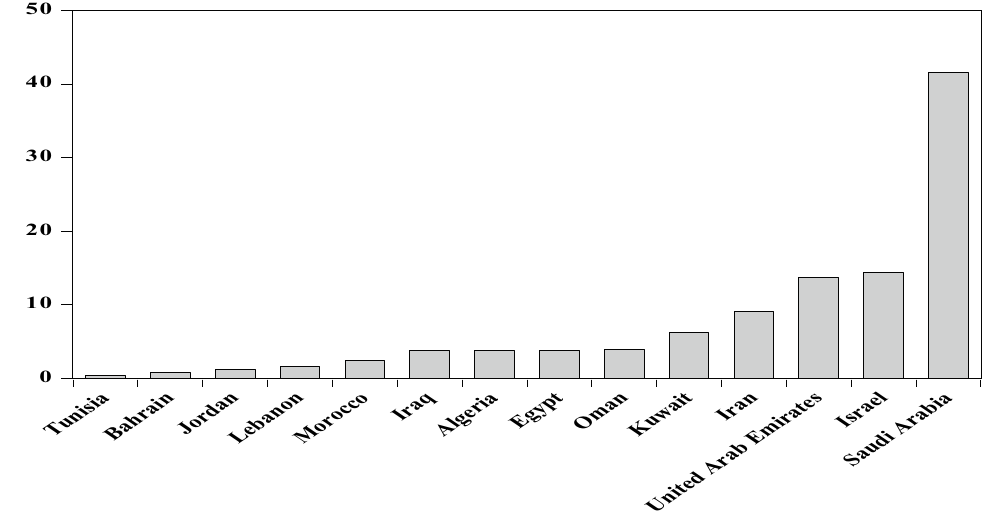
Fig. 1 Military spending in selected MENA countries (B’USD)